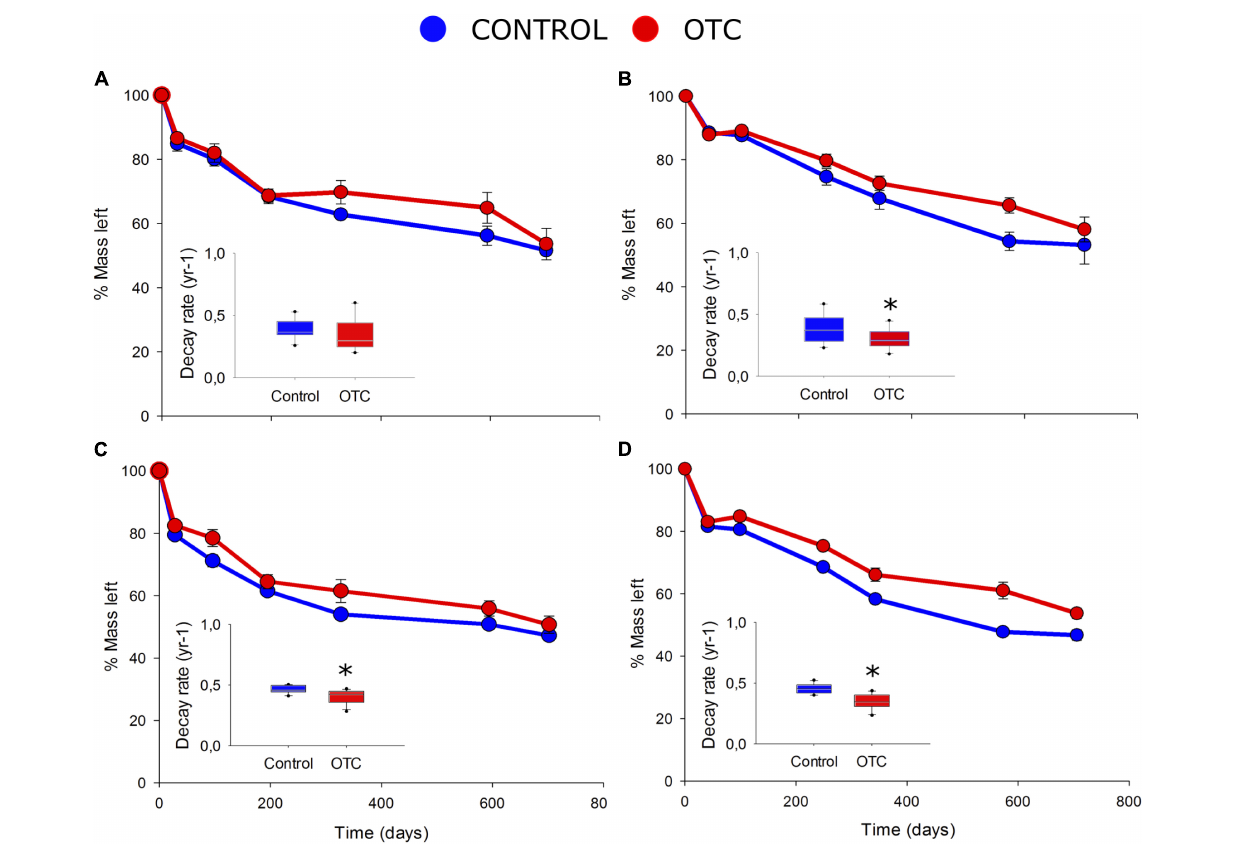
FIGURE 3 | Percentage of litter mass left at the end of 2 years of incubation in the field (outer plot) and the decay rate k (inner plot) for Espeletia grandiflora in Matarredonda (A) and Sumapaz (B) and for Laurus nobilis in Matarredonda (C) and Sumapaz (D) . Points are mean value and their error bars the standard error. Asterisk denote statistically significant differences between OTC and control plots at P <